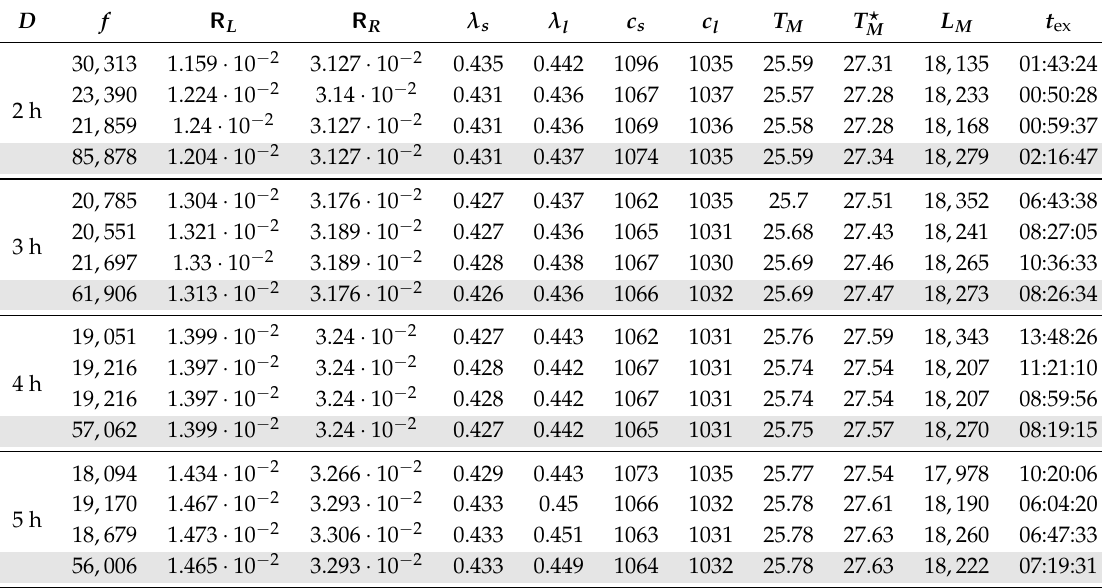
Table A2. 19.2% w -PCM mortar: values of the identified parameters for each heating/cooling ramp and for the first, second, third, and all cycles together